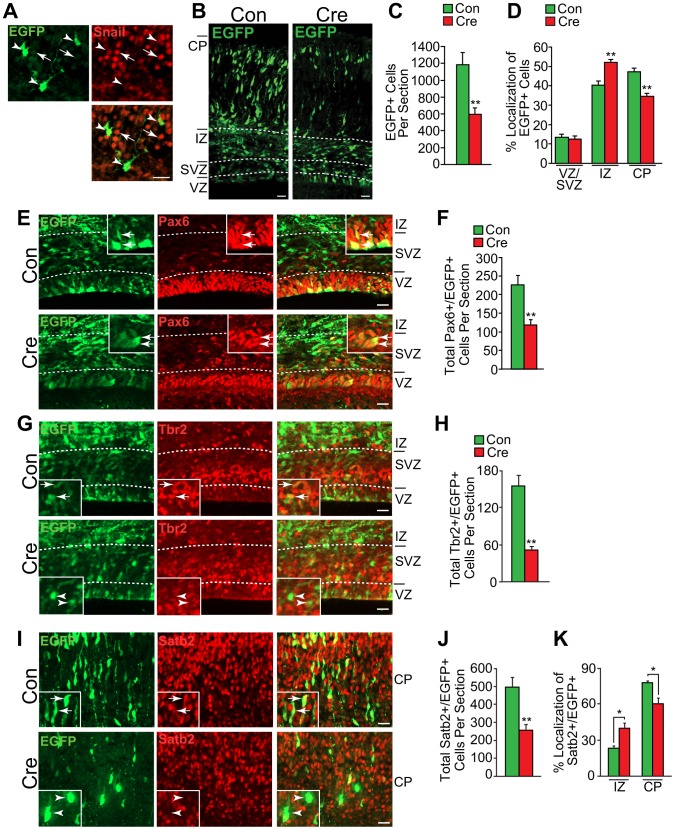
Acute Snail knockout decreases the numbers of neural precursors and neurons in the embryonic cortex.Cortices of Snailfl/fl mice were electroporated at E13/14 with an expression construct that encodes both Cre recombinase and EGFP (Cre), and were analyzed three days later. As a control, cortices were electroporated with the same construct that encodes EGFP alone (Con). (A) Confocal fluorescence micrographs of the cortical plate from Cre-EGFP electroporated brains stained with EGFP (green) and Snail (Red; bottom panel shows the merge). Arrows indicate EGFP-negative cells with robust nuclear Snail immunoreactivity, and arrowheads denote EGFP-positive cells with decreased Snail staining. Scale bar 20 µm. (B) Fluorescence micrographs of coronal sections through E16/17 control or Cre-electroporated cortices immunostained for EGFP (green). The boundaries between the different cortical regions are denoted by the dotted white lines. Scale bar, 20 µm. (C,D) Quantification of sections similar to those in B for the total number of EGFP-positive cells per section (C) and the relative location of EGFP-positive cells in the different cortical regions (D). (**p<0.01; n = 4 embryos each). (E) Confocal micrographs of coronal sections through the VZ/SVZ of E16/17 control or cre-electroporated cortices immunostained for EGFP (green) and Pax6 (red, right panels show the merges). The boxed insets show EGFP-positive cells at higher magnification. Arrows denote double-labeled cells, and the white hatched lines denote the borders of the different cortical regions. Scale bar, 20 µm. (F) Quantification of sections as in E for total Pax6-positive, EGFP-positive cells per section (F). (**p<0.01; n = 4 brains each). (G) Confocal micrographs of coronal sections through the VZ/SVZ of E16/17 control or Cre-electroporated cortices immunostained for EGFP (green) and Tbr2 (red, right panels show the merges). The boxed insets show EGFP-positive cells at higher magnification. Arrows denote double-labeled cells, and the white hatched lines denote the borders of the different cortical regions. Scale bar, 20 µm. (H) Quantification of sections as in G for total Tbr2-positive, EGFP-positive cells per section. (**p<0.01; n = 4 brains each). (I) Confocal micrographs of the cortical plate of E16/17 control or Cre-electroporated cortices immunostained for EGFP (green) and Satb2 (red, right panels show the merges). The boxed insets show EGFP-positive cells at higher magnification. Arrows denote double-labeled cells and arrowheads EGFP cells negative for Satb2. Scale bar, 20 µm. (J,K) Quantification of sections as in I for total Satb2-positive, EGFP-positive cells per section (J) and their relative localization in the intermediate zone (IZ) and the cortical plate (K). (**p<0.01; n = 4 brains each).